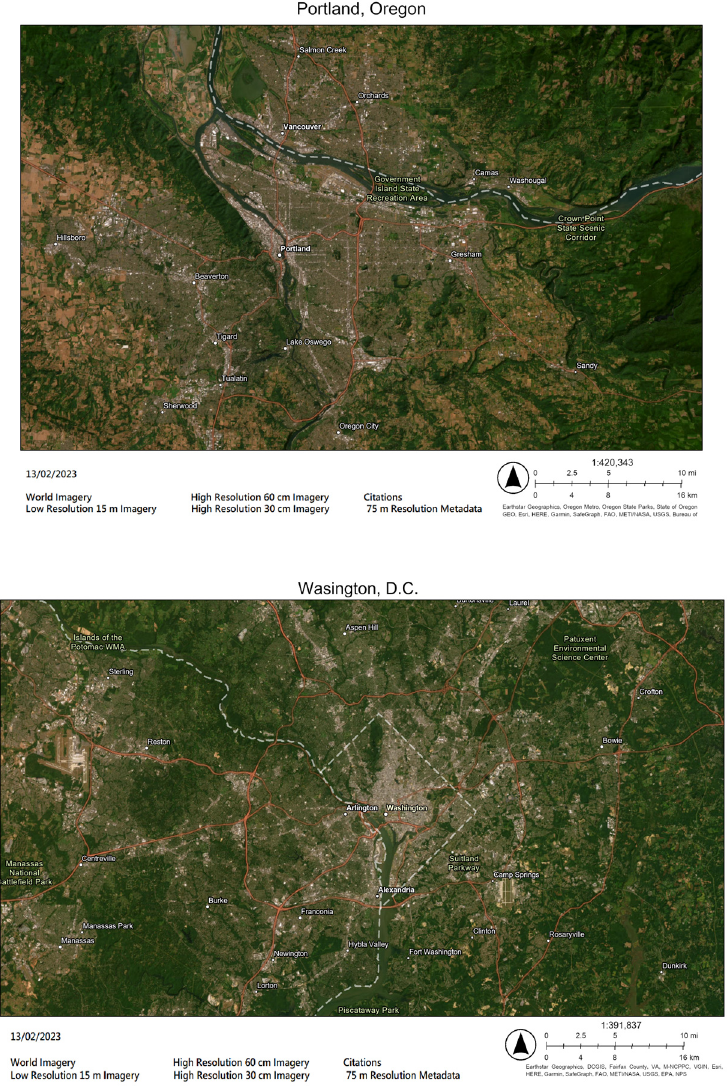
Figure 1. Study area locations: Portland, Oregon ( top ), Washington, D.C. ( bottom ) (Source: ArcGIS online).